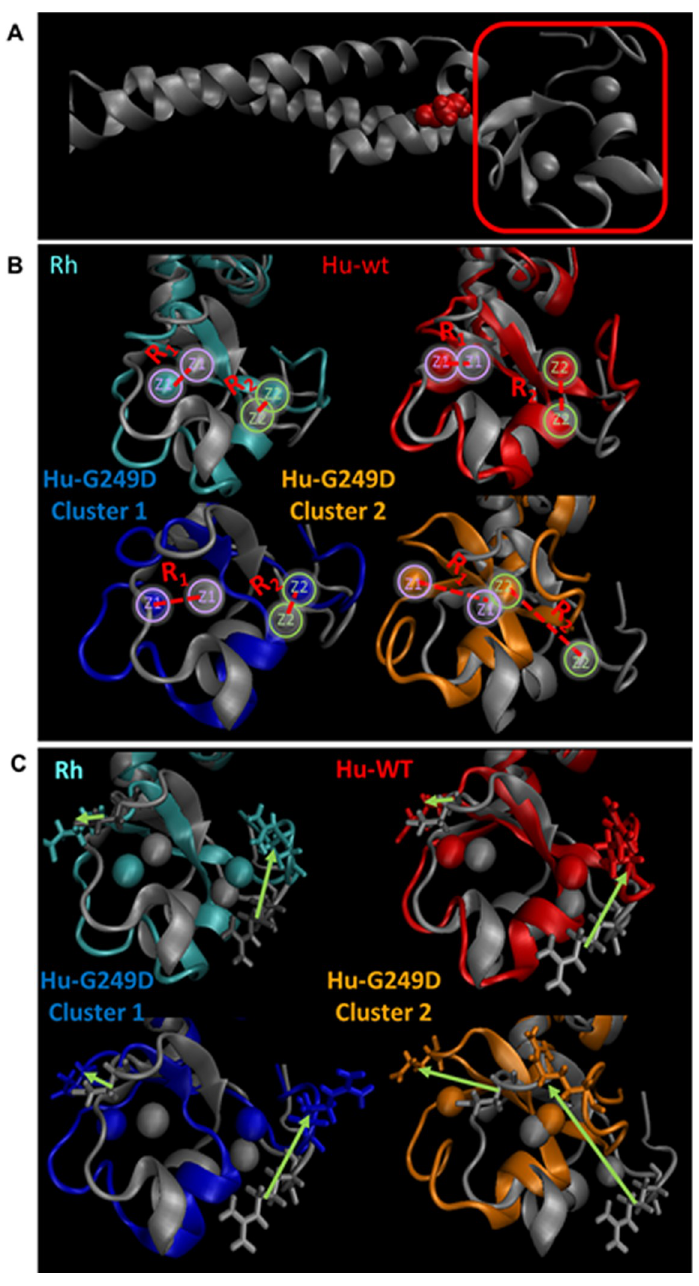
Fig 5. Human G249D CCL2 dimer has distorted placement of BBox-2 domain compared crystal structure. (A) Crystal structure of rhesus CCL2 given in silver. Trajectories from MD simulations classified into clusters according to their RMSD (threshold value of 2.25 Å ). (B) Rhesus CCL2 dimer major cluster (in cyan, 64%), human WT CCL2 dimer major cluster (in red, 89%), human G249D CCL2 dimer cluster 1 (in blue, 64%), human G249D CCL2 dimer cluster 2 (in orange, 10%). R 1 and R 2 represents the distances between zinc ions and zinc ions are color coded (purple for the first and green for the second zinc ion). (C) Representative side chains are depicted for each cluster. Arrows represent how the side chains displaced compared to rhesus crystal